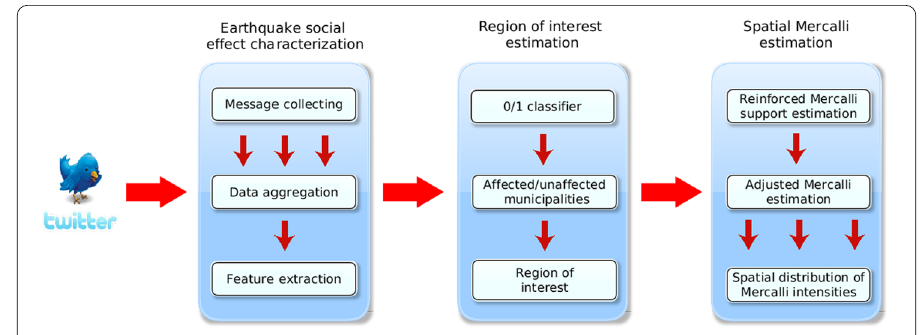
Figure 2 Architecture of our Mercalli inference system. Architecture of our Mercalli inference estimation system based on social media characterization. The system considers three stages: data acquisition, region of interest estimation, and spatial Mercalli